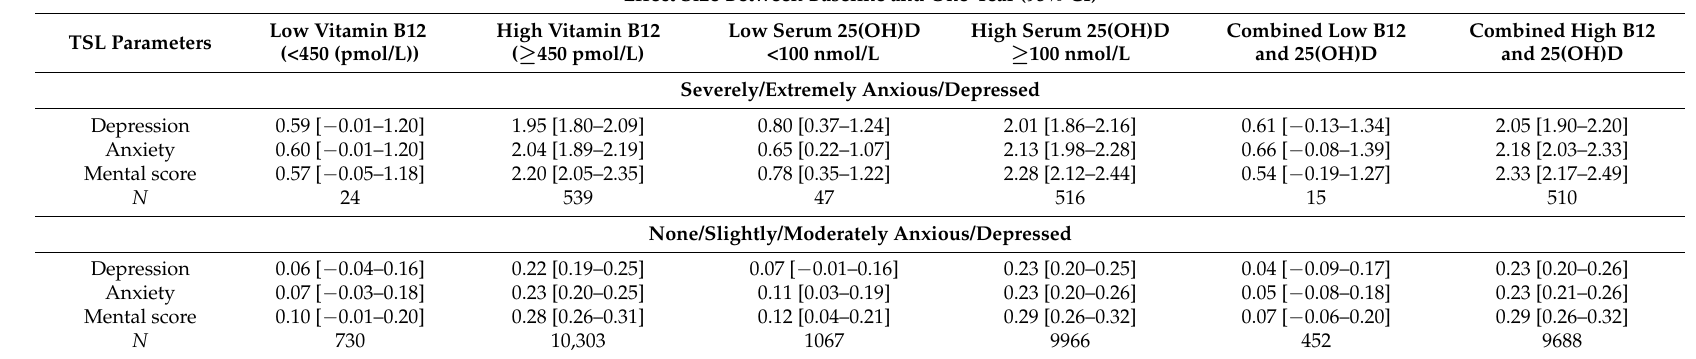
Table 7. Magnitude of Effect of Nutritional Status on Targeted Symptoms List (TSL) Depression and Anxiety at one-year follow-up in Severely/Extremely Anxious/Depressed.